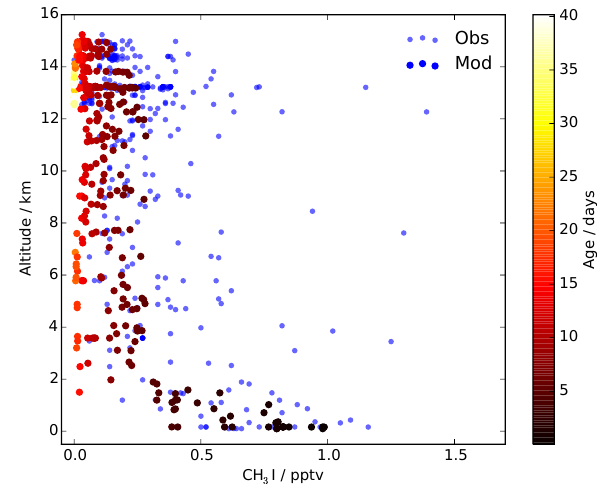
Figure B1. Vertical profiles of observed (blue) and synthetic (coloured as a function of age) CH 3 I mole fraction data sampled along flight tracks corresponding to AWAS samples collected dur- ing CONTRAST as a function of